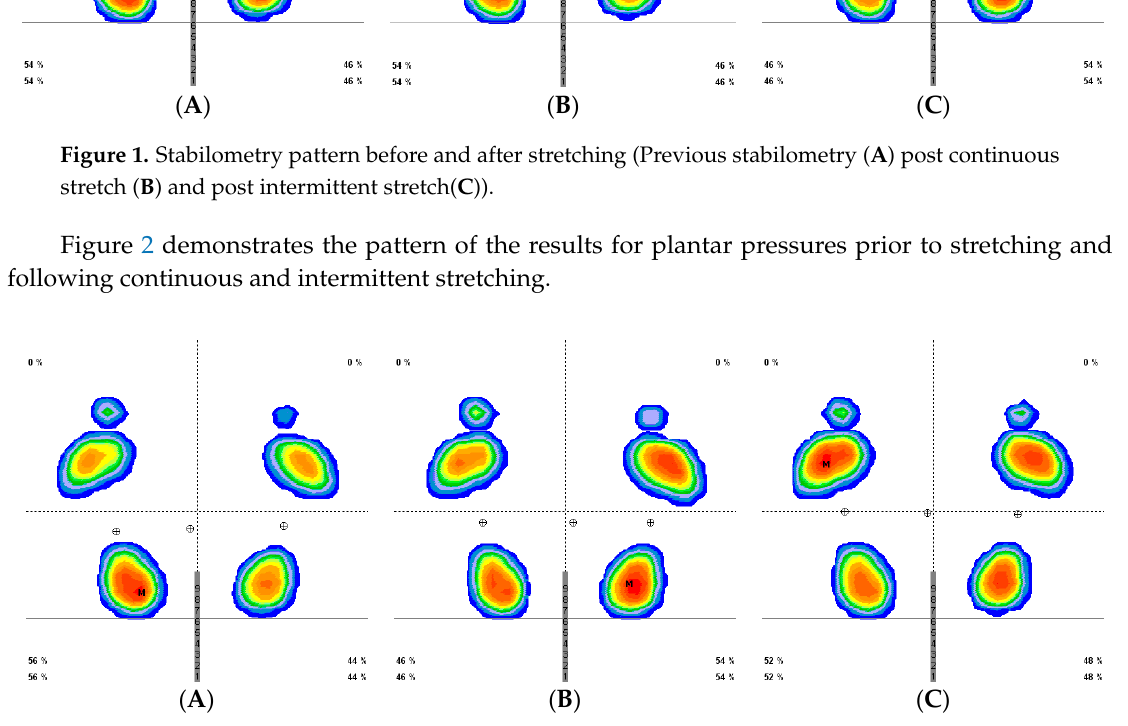
Figure 2. Plantar pressures pattern before and after stretching (prior ( A ), post continuous stretch ( B ), and post intermittent stretch( C )).